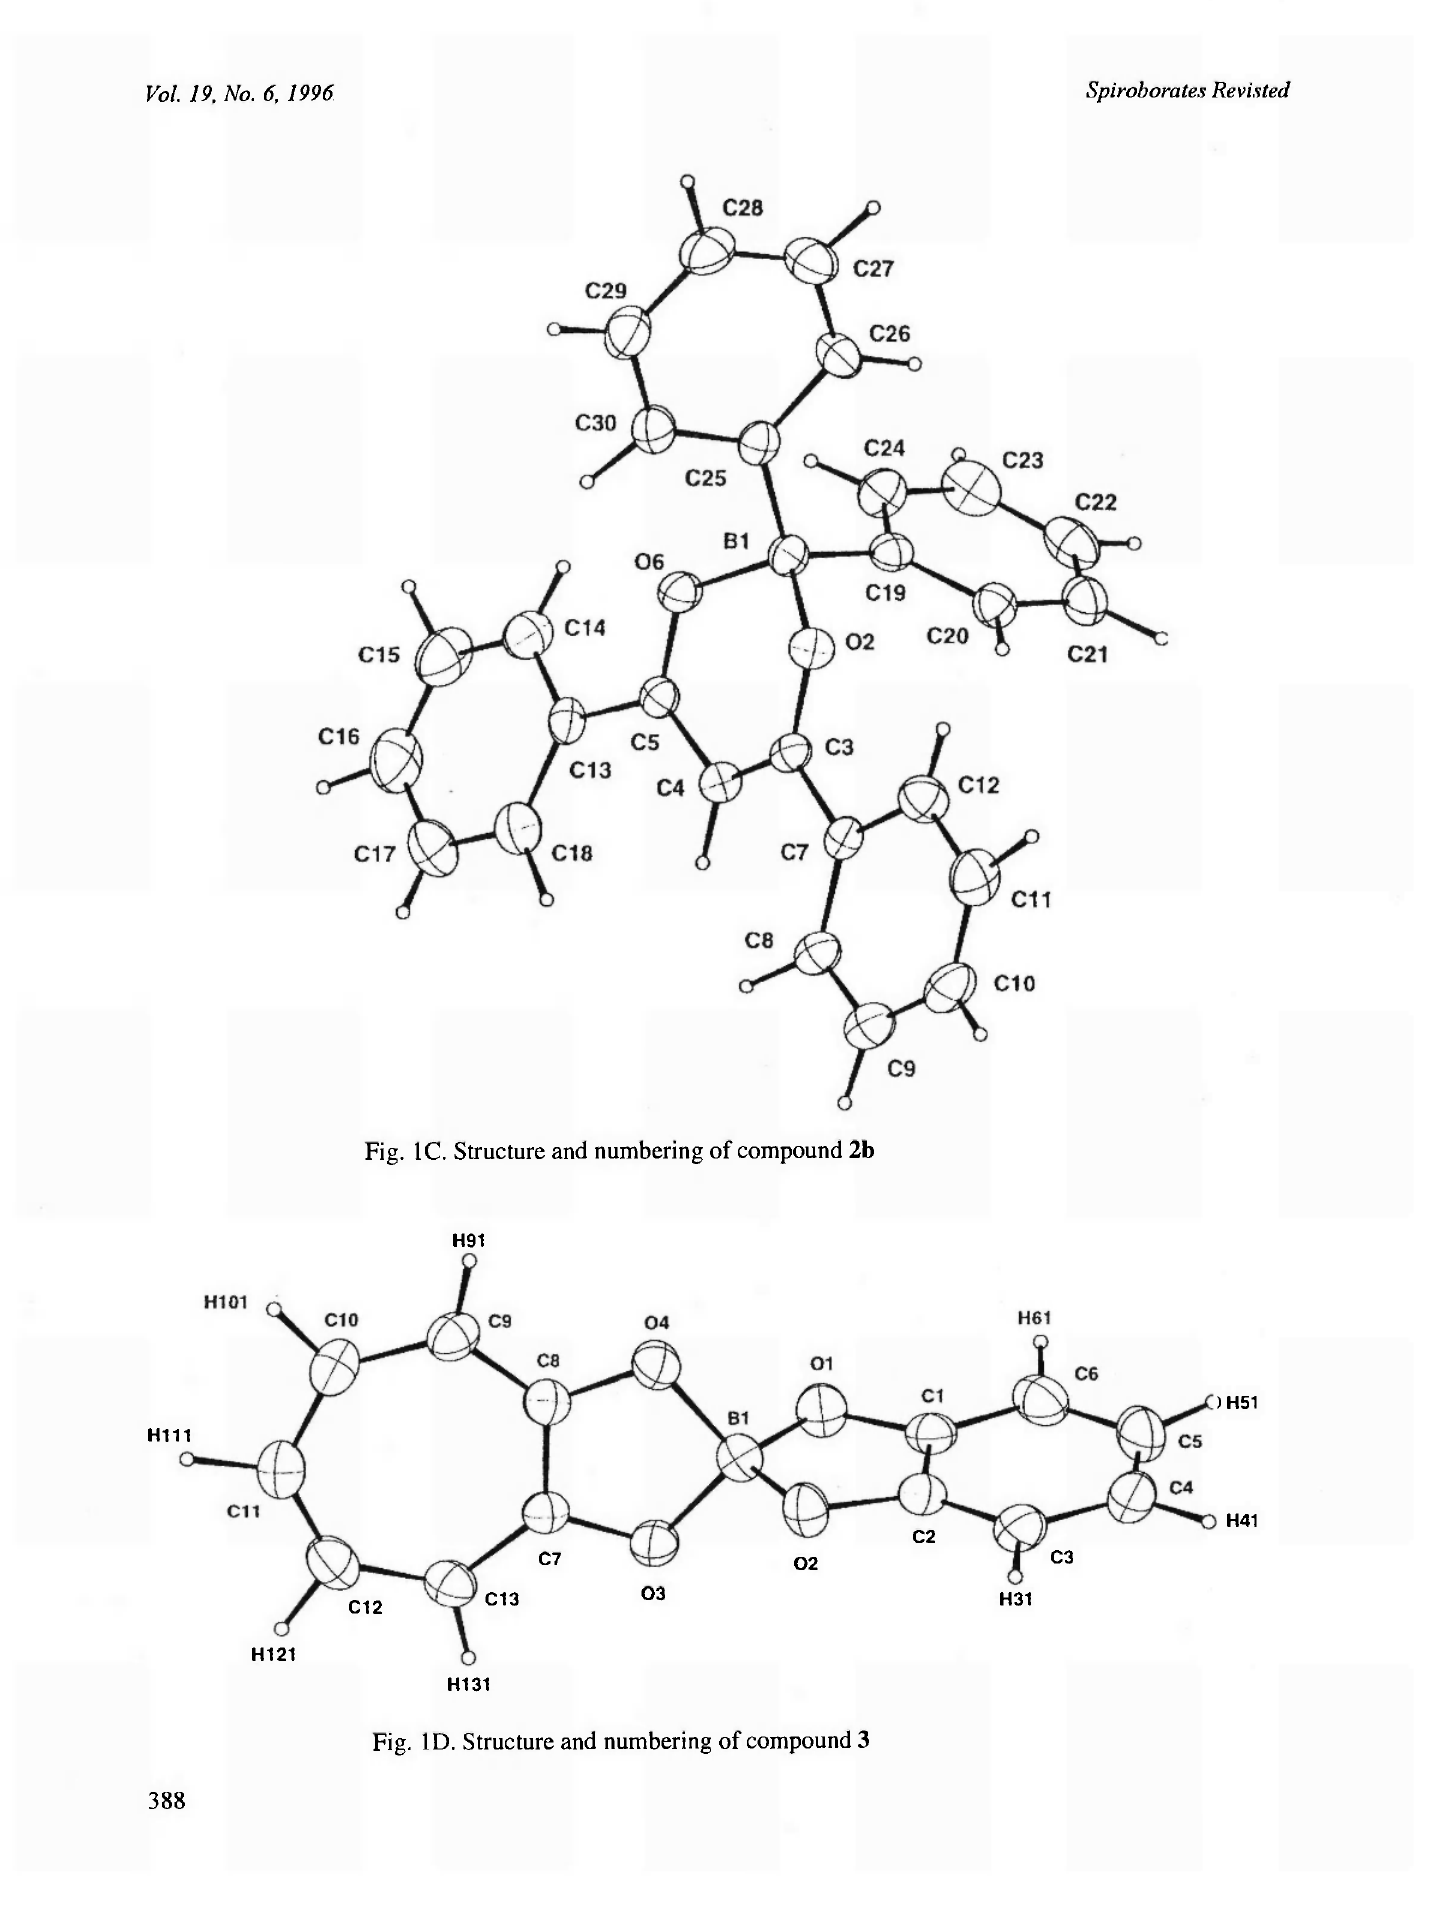
Fig. 1C. Structure and numbering of compound 2b